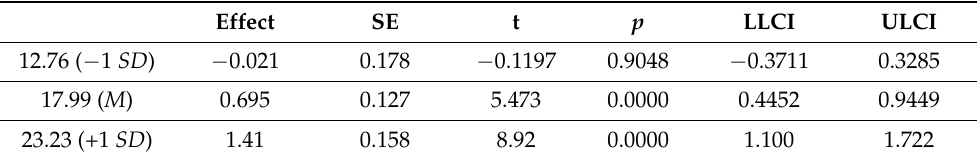
Table 5. Conditional effects of positive religious coping as a moderator for relationship between frequency of prayer and life satisfaction.